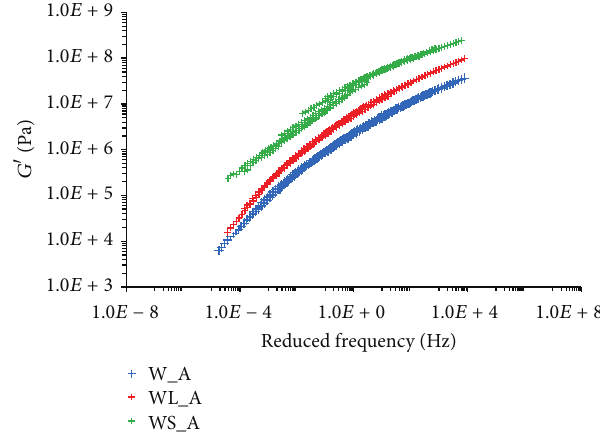
Figure 8: Storage modulus 𝐺 󸀠 versus frequency (aged warm samples).